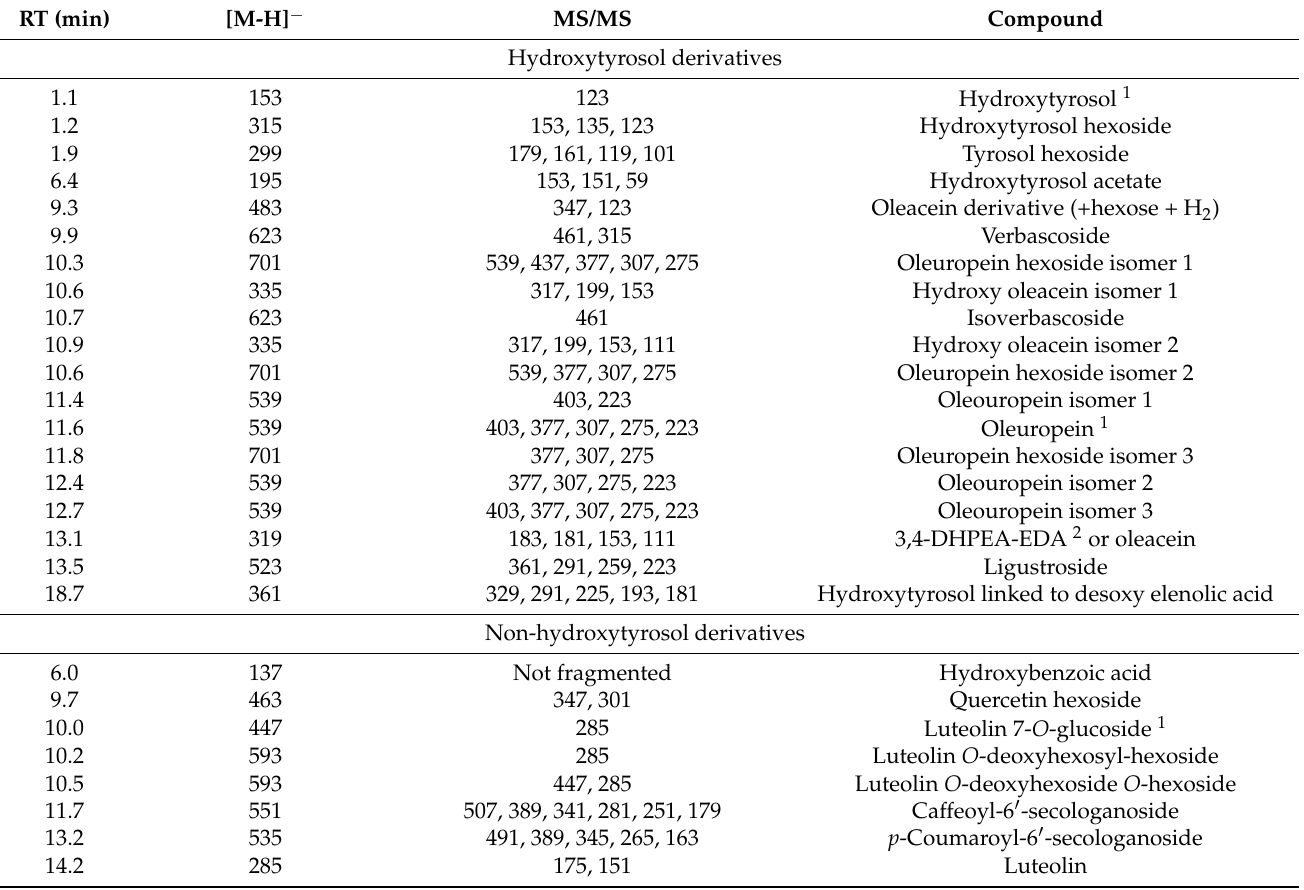
Table 8. Phenolic compounds characterized by high-performance chromatography coupled to mass spectrometry in water–acetone extracts obtained by bath- and probe-type ultrasound-assisted extraction under the best obtained conditions. RT